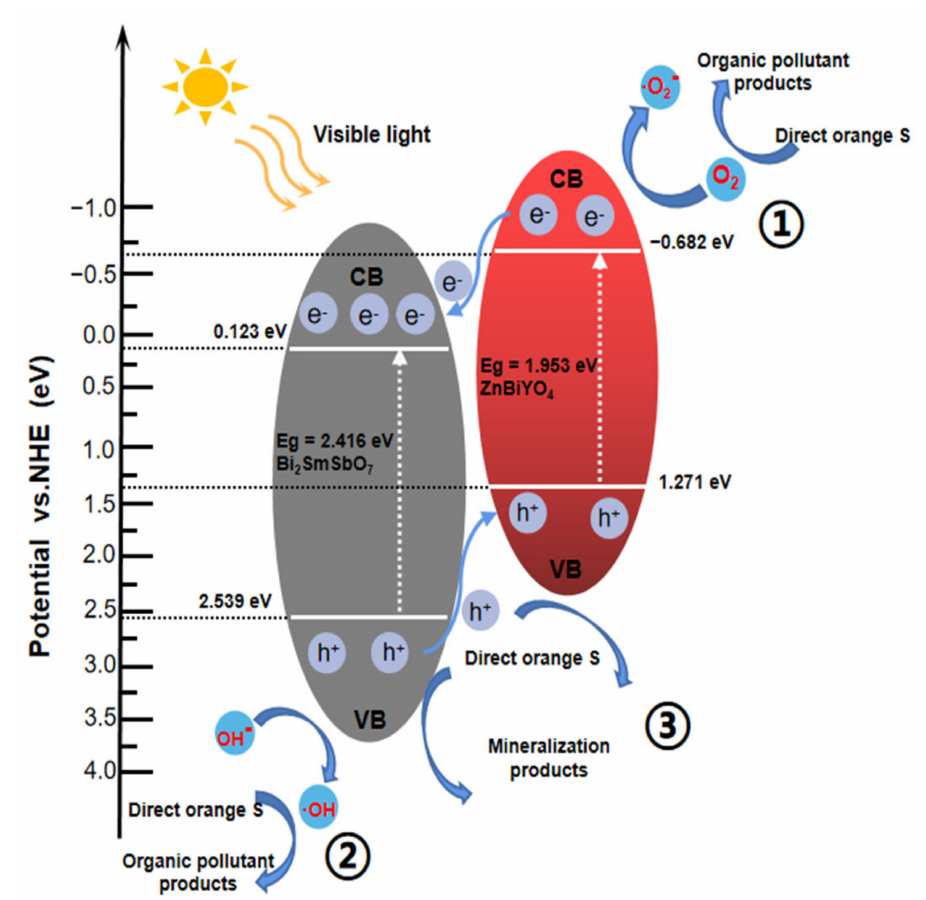
Figure 21. Possible PD mechanism of DO with Bi 2 SmSbO 7 /ZnBiYO 4 heterojunction as photocatalyst under